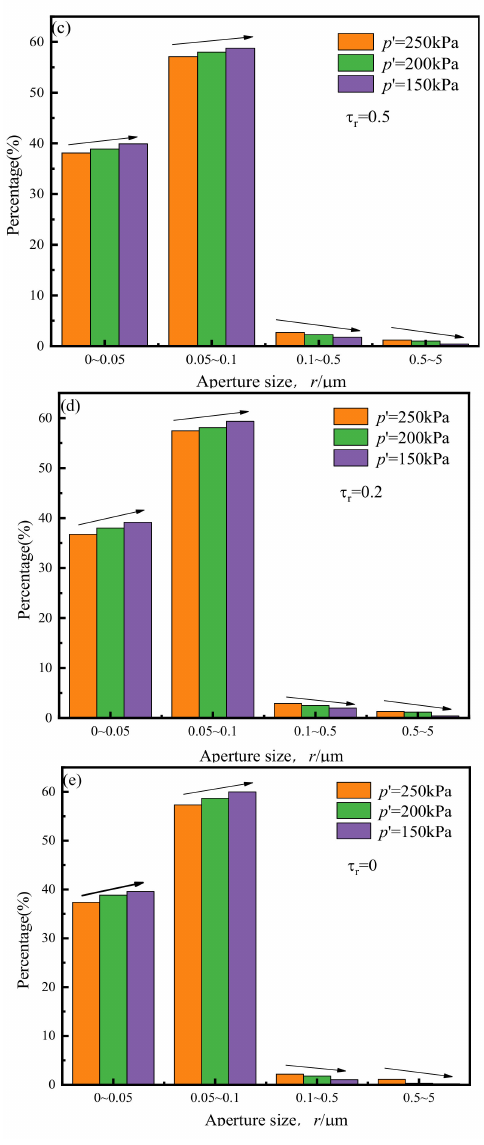
Figure 15. Pore size distribution under the influence of p (cid:48) : ( a ) τ r = 1; ( b ) τ r = 0.8; ( c ) τ r = 0.5; ( d ) τ r = 0.2; ( e ) τ r =